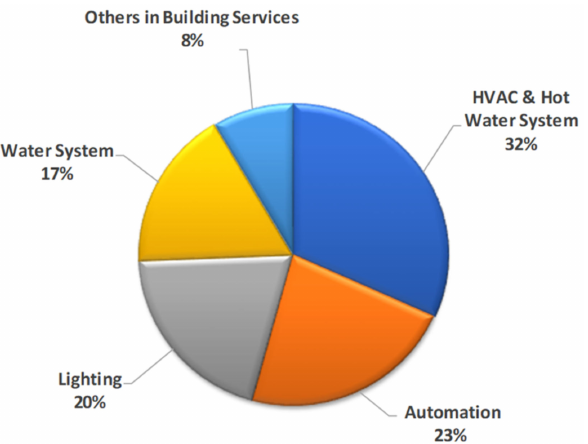
Figure 4. Building services innovations within the top five houses of SD